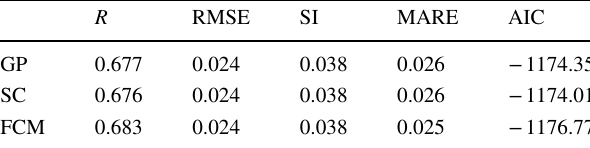
Table 1 Results of statistical indices for different generations of fuzzy inference